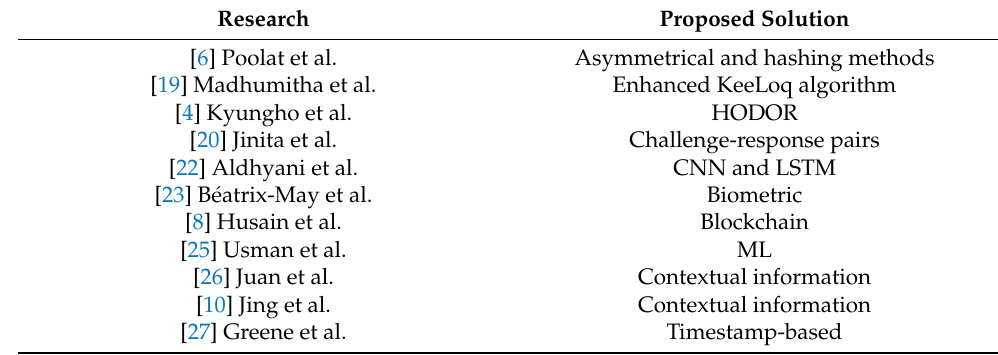
Table 1. Summary of recently proposed solutions for the security of the keyless